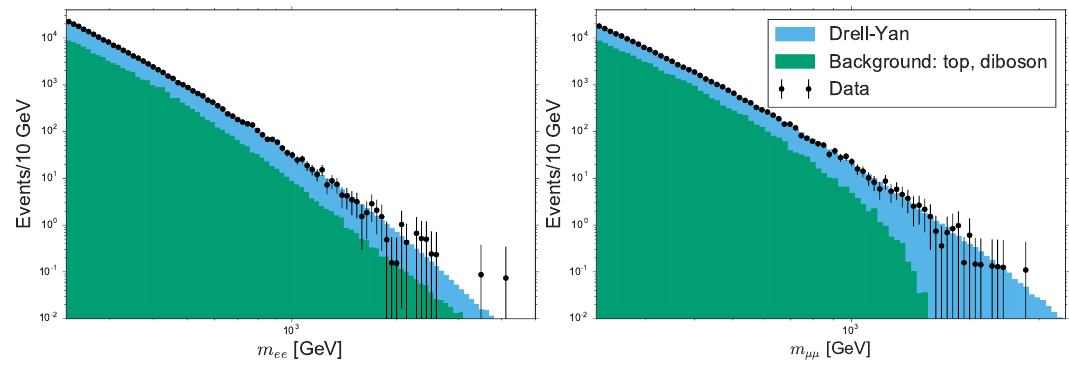
Figure 9 . The data (number of events per 10 GeV bin) from the ATLAS Z 0 search from [139] in the di-electron (left) and di-muon (right) channels. We also display the theoretical predictions associated to the contributions from Drell-Yan and from the rest of the backgrounds, taken from the ATLAS